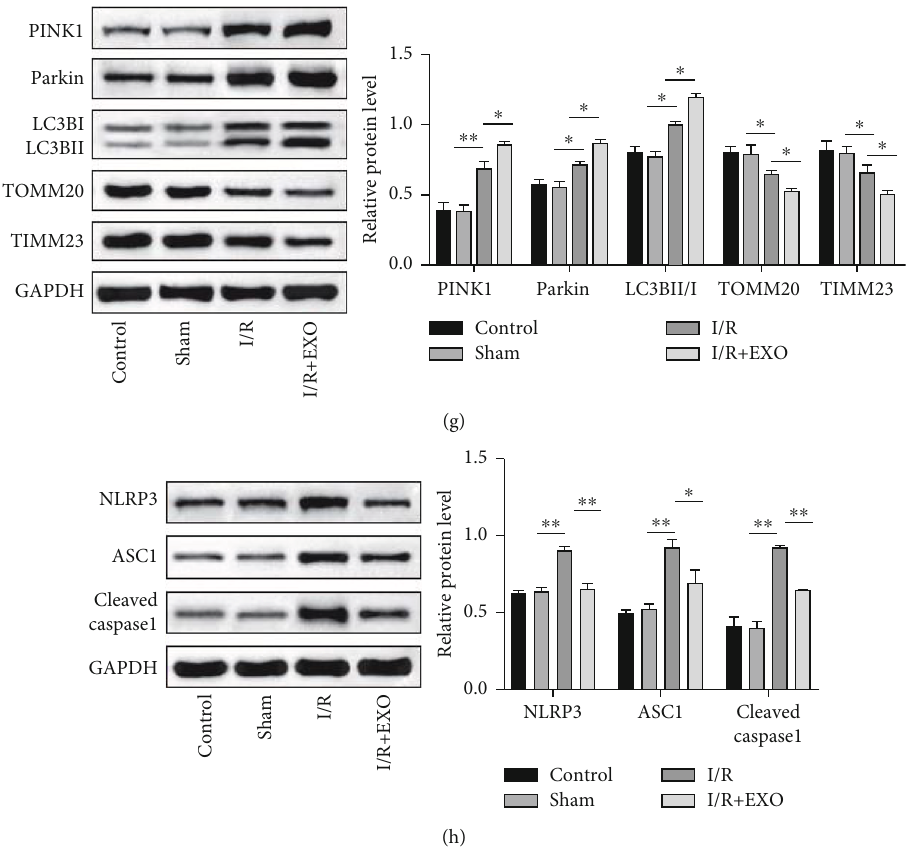
Figure 2: BMSC-derived EVs promoted mitophagy and attenuated in fl ammasome activation to ameliorate RIRI. Mice were treated with EVs and then subjected to I/R injury. (a) Histological injury was evaluated based on the H&E staining. (b and c) The blood urea nitrogen (BUN) and serum creatinine (sCr) contents were detected using the speci fi c kits. (d) Tissue apoptosis was detected using the TUNEL assay kit. (e) The protein levels of BAX, cleaved caspase-3, and Bcl-2 were con fi rmed using the western blot analysis. (f) The autophagosomes (APs) and autophagosome-fused mitochondria (AP-mi) were observed using TEM. (g) Expressions of the mitophagy markers were detected using the western blot analysis. (h) The expressions of NLRP3, ASC1, and cleaved caspase 1 were evaluated using the western blot analysis. n = 6 . ∗ P < 0 : 05 ; ∗∗ P < 0 : 01 ; ∗∗∗ P < 0 : 001